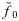
Fitness-to-distance correlation impacts accessibility and coverage of the experimental FLs.Panels (a-c): data from Rowe et al. [39], panels (d-f): data from Guenther et al. [42]. (a,d) Accessibility of the sub-FLs for K = 2, 4 (red circles, red triangles), and for their randomized counterparts (grey, black) as a function of rescaled initial fitness f˜0. In the presence of fitness-to-distance correlations landscapes with high levels of f˜0 are mostly accessible compared to the case with no correlations. (b,e) Number of paths exhibits as a function of rescaled initial fitness f˜0. Presence of fitness-to-distance correlations increased number of pathways by a few orders of magnitude compared with the randomized ensemble. (c,f) Coverage of experimental sub-FLs and their randomized counterparts as a function of f˜0. The insets show the same data in semi-log scales. In the case of K = 2 correlations increase the fraction of accessible genotypes to levels observed for FLs with K = 4.